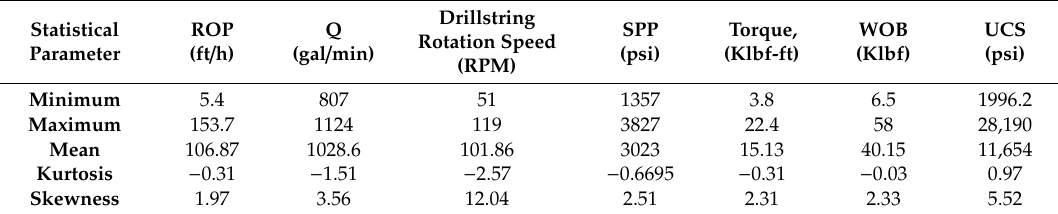
Table 2. Statistical parameters of the drilling parameters collected from the 16” intermediate section of Well B.